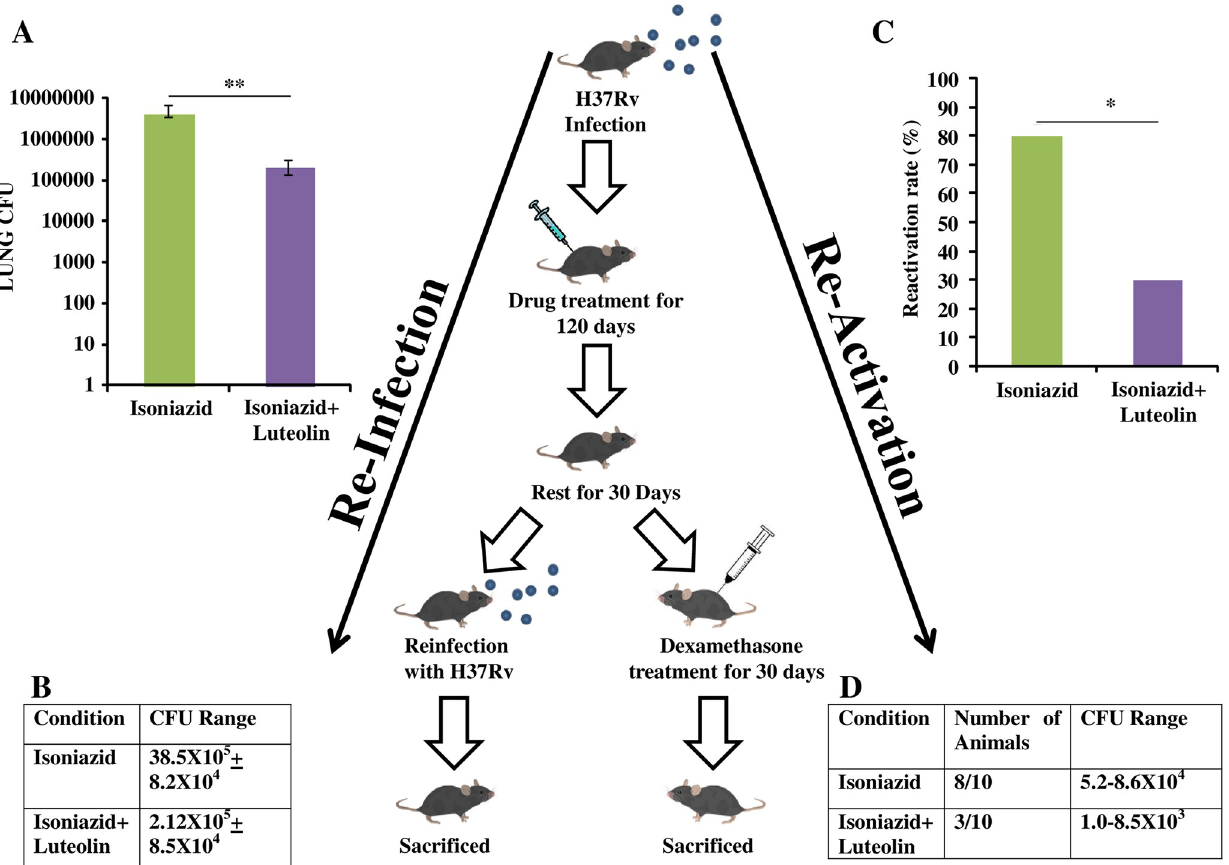
Fig 6. Luteolin-mediated TB immunity prevents disease relapses. M . tb infected mice were treated with Isoniazid or Isoniazid+Luteolin for 120 days and then rested for another 30 days. Then, one group was reinfected with M . tb and a second group was treated with dexamethasone for 30 days. Mice were then sacrificed for CFU estimation to determine the rate of relapse post-treatment. (A & B) Lung CFU in reinfected mice after 15 days of secondary infection. (C & D) Rate of reactivation of latent bacteria and corresponding CFU range recorded. Data shown are from a single experiment of ten mice in each group and represent the MEAN ± STDEV values. Differences were considered significant at P < 0.05 and are represented by � p < 0.05, �� p < 0.01, ��� p < 0.001, ���� p < 0.0001 whereas non-significant differences are denoted by (NS).